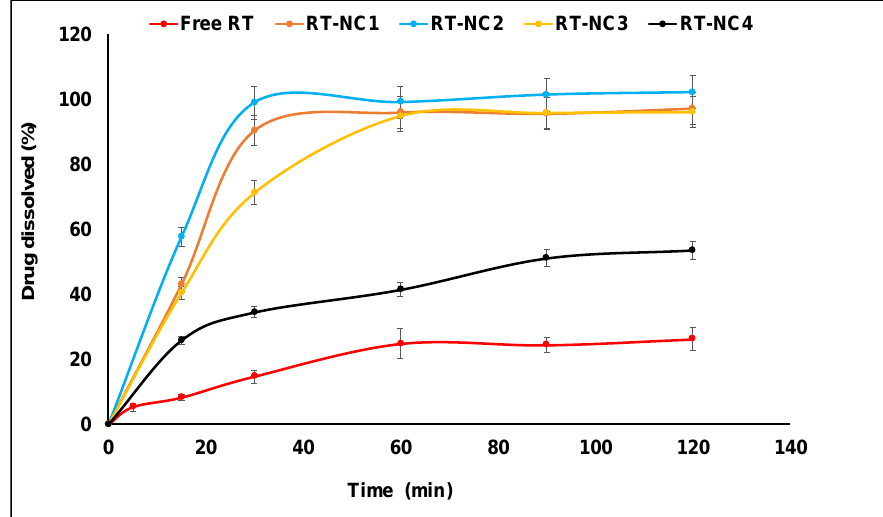
Figure 4. Dissolution profiles of various RT-NCs in phosphate buffer pH 6.5 at 37 °C in comparison to free RT.